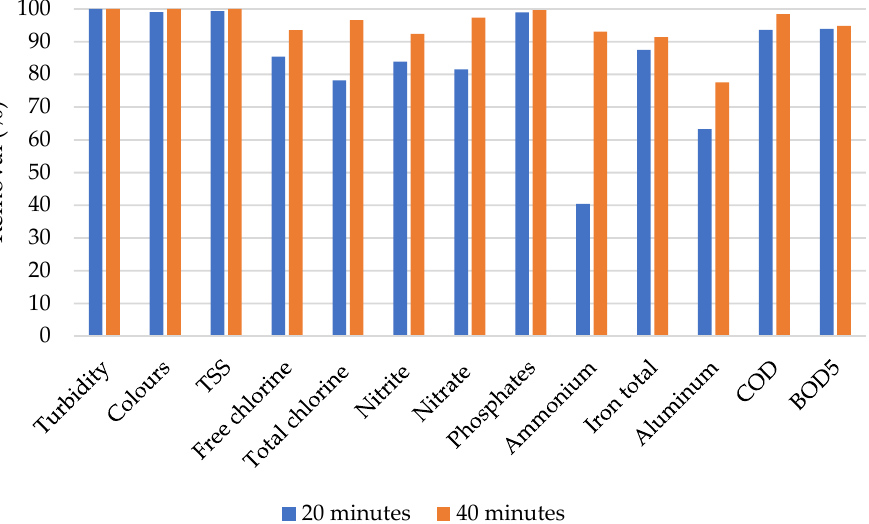
Figure 6. Removal e ffi ciencies from the Al–Ti electrode Figure 6. Removal efficiencies from the Al–Ti electrode combination. Figure 6. Removal efficiencies from the Al–Ti electrode combination.